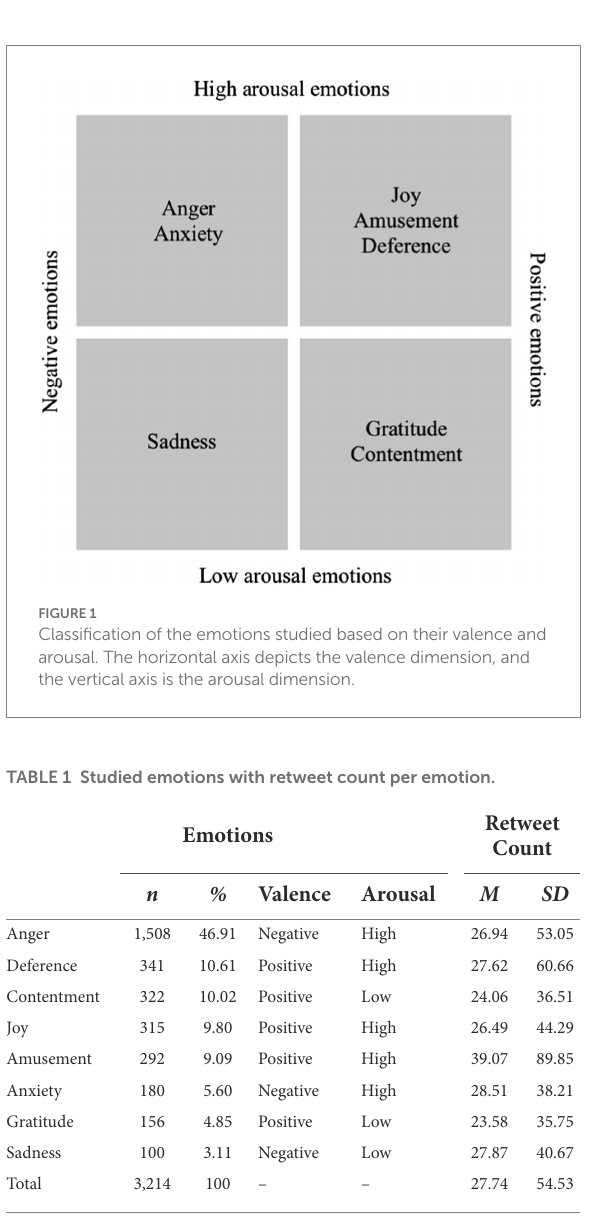
Supplementary Table S1. The model with both random effects